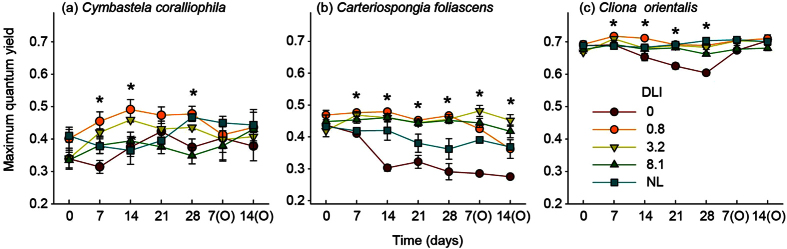
Temporal evolution of fluorescence levels.Mean values (±SE) of fluorescence (maximum quantum yield) for the three phototrophic species per light treatment 0, 0.8, 3.2, 8.1 mol photons m−2 d−1 and natural light (NL, 3.2–6.5 mol photons m−2 d−1). Measurements were taken at the start of the experiment and then weekly until the end of the experimental and observational (O) periods. Asterisks show statistically significant differences among treatments (ANOVA: P < 0.05).